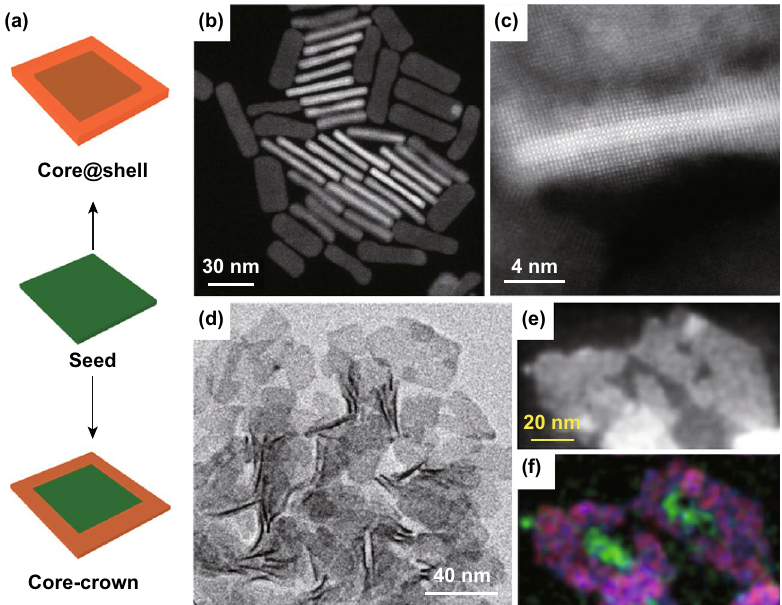
Fig. 8 a Schematic illustration of the synthesis of core@shell and core‑crown structures from 2D seeds. b HAADF image of annealed CdSe@ CdS core@shell nanoplates with very smooth surfaces. c High‑resolution HAADF image of a CdSe@CdS core@shell nanoplate on the side exhibiting the core@shell structure and five Cd planes of the initial CdSe nanoplate. Reproduced with permission from Ref. [146]. Copyright 2012, American Chemical Society. d TEM image of CdSe‑CdS core‑crown heterostructures. e HAADF‑STEM image and f color‑coded STEM EDS map of CdSe‑CdS core‑crown heterostructures. The red, green, and blue colors represent to S, Se, and Cd, respectively. Reproduced with permission from Ref. [151]. Copyright 2013, American Chemical